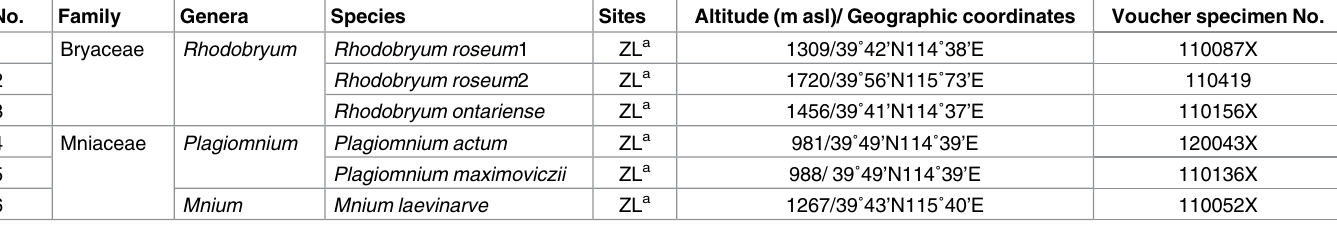
Table 1. Description of the Geographic Coordinates and Altitudes of the Aample Sources.